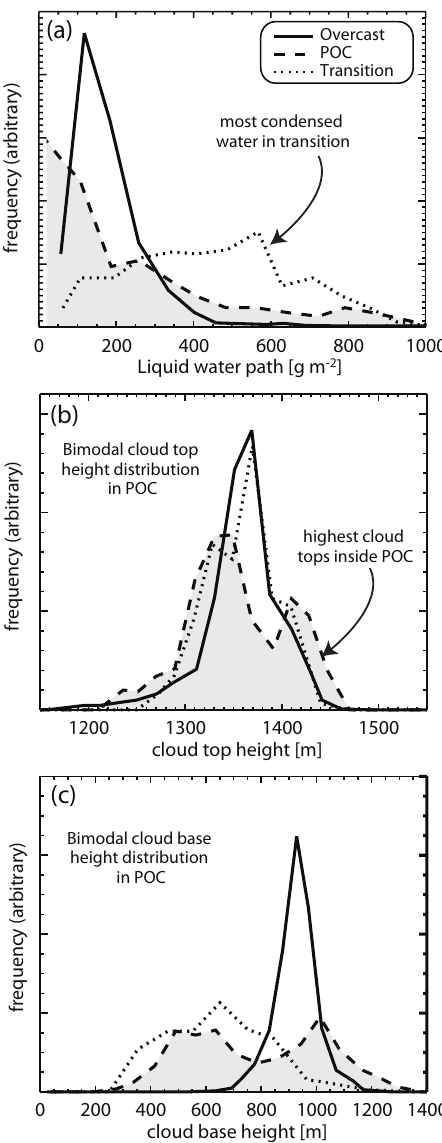
Fig. 11. Probability distribution functions from RF06 for (a) liquid water path; (b) cloud top height; (c) cloud base height, for overcast, POC, and transition regions. Cloud base height data are from the WCL. LWP data are from the microwave radiometer data on the two subcloud legs. Cloud top height data are from the WCR on the subcloud, above-cloud, and cloud-base legs. Cloud-level legs were not used to prevent the chance of the cloud top occurring in the radar dead-zone. Cloud base data are from the two subcloud legs. In heavy drizzle the lidar algorithm is unable to detect a clear cloud base, and in these cases we use the height of the maximum radar reflectivity as a proxy for the cloud base. For the POC and transition regions this substitution accounts for roughly 50% of all data points, while for the overcast region radar data are used only 5% of the time.